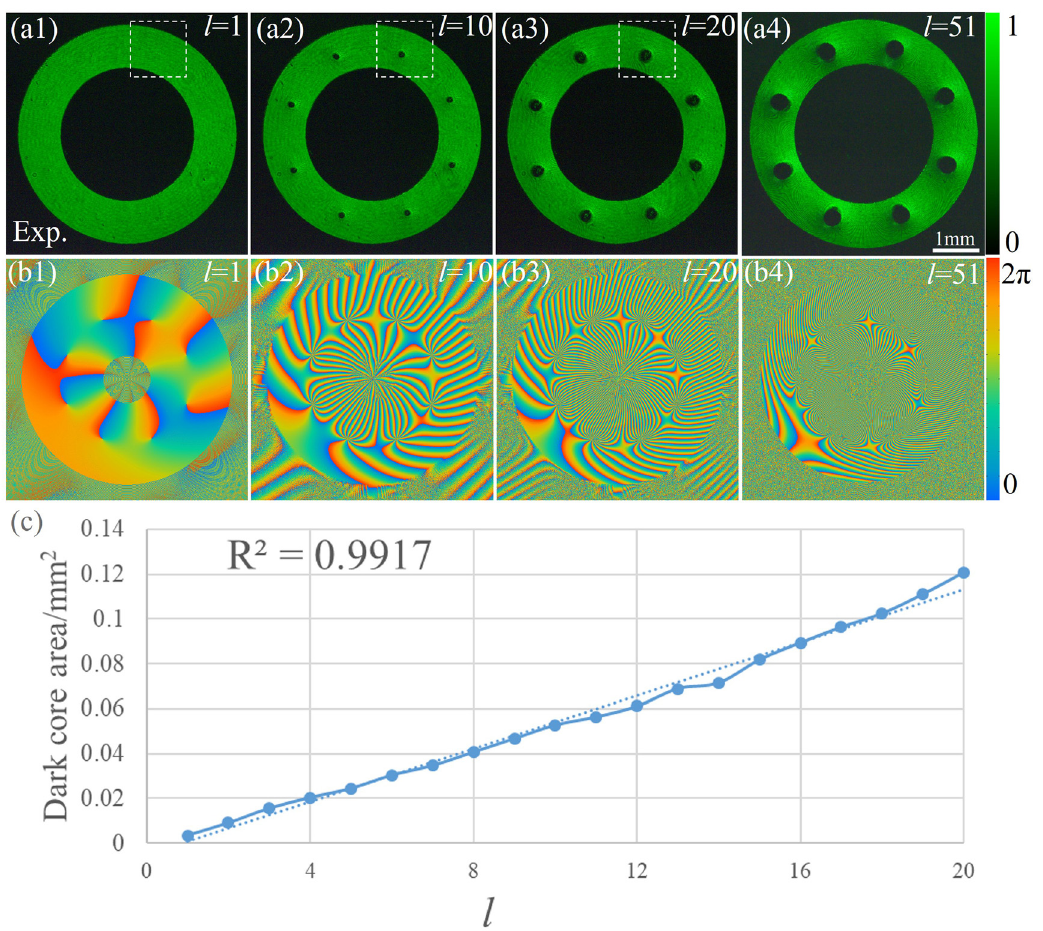
Figure 5: (a1) – (a4) HO-OVL intensity patterns with different ls (1, 10, 20, and 51, respectively). (b1) – (b4) Corresponding phase patterns of the top row. (c) Area of the dark core versus l